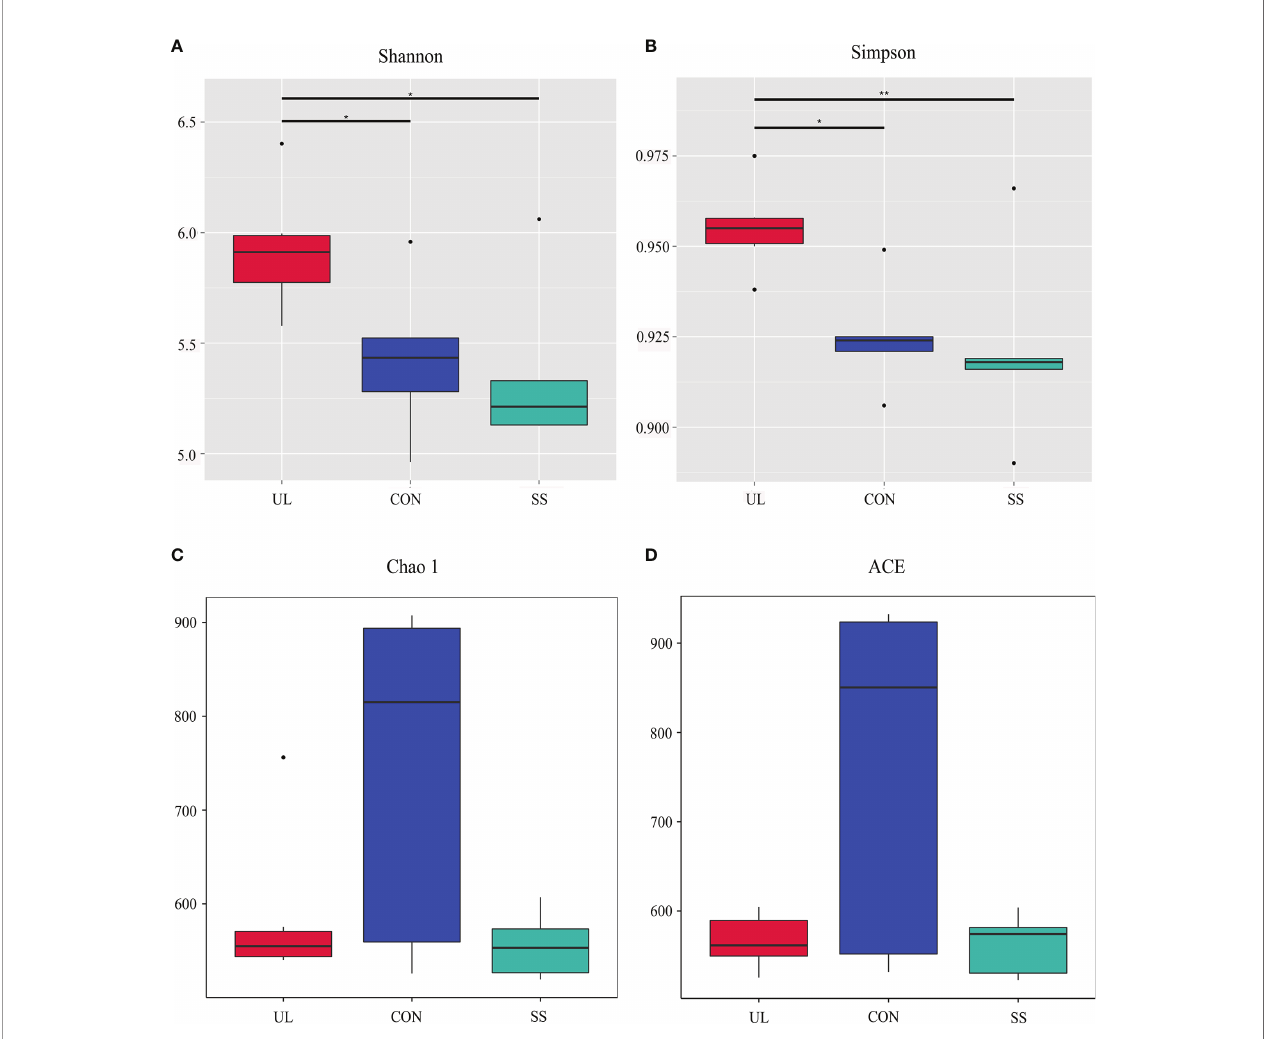
FIGURE 1 | Alpha diversity of gut bacteria. Estimation of community diversity (A, B) and richness (C, D) is illustrated using boxplots for UL (red), CON (blue), and SS (green) groups. The boxplots show median, 25 th and 75 th quartile, smallest, and largest values. UL group (n = 6), CON group (n = 5), SS group (n = 5). The Wilcoxon rank-sum test was used to analyze the statistical signi fi cance of alpha diversity; * p-value < 0.05 and ** p-value < 0.01, versus the CON group. CON, control group; UL, unilateral labyrinthectomy group; SS, sham surgery